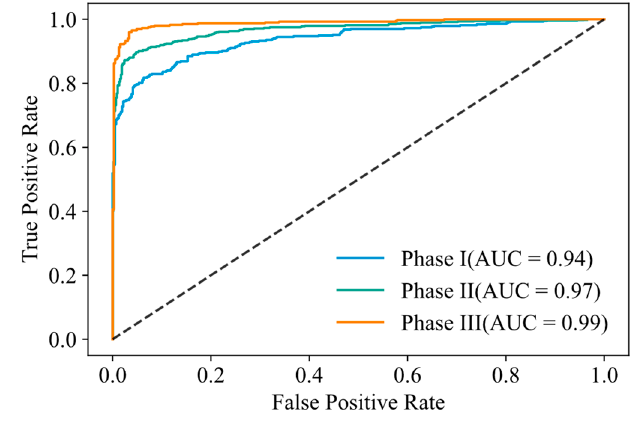
Figure 11. ROC graphs for the three phrases.